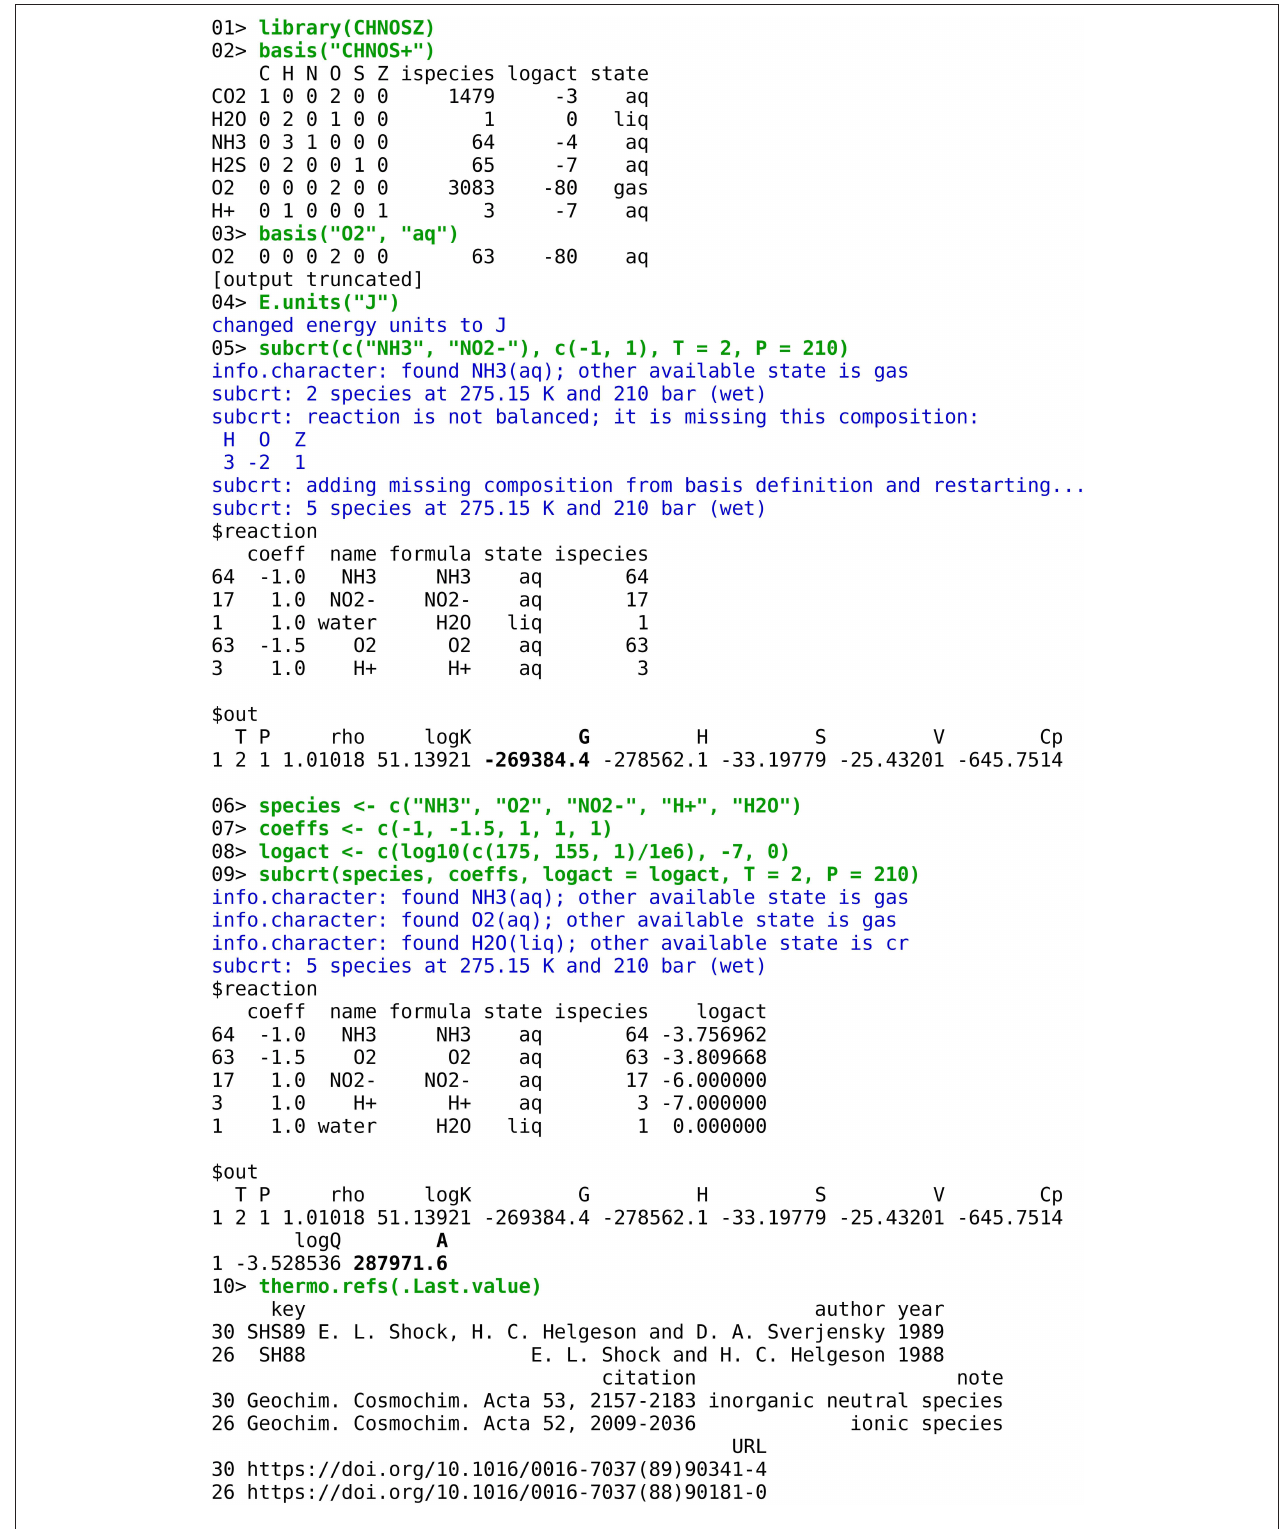
FIGURE 3 | Transcript of a microbial bioenergetic calculation in CHNOSZ. User-entered commands are in green text, messages from functions are in blue text, and output (results) is in black text. The bold numbers are the calculated values, in J/mol, of standard Gibbs energy for ammonia oxidation, and chemical affinity (opposite of overall Gibbs energy of reaction) calculated using activities of species from Table S3 of Reed et al. (2015).